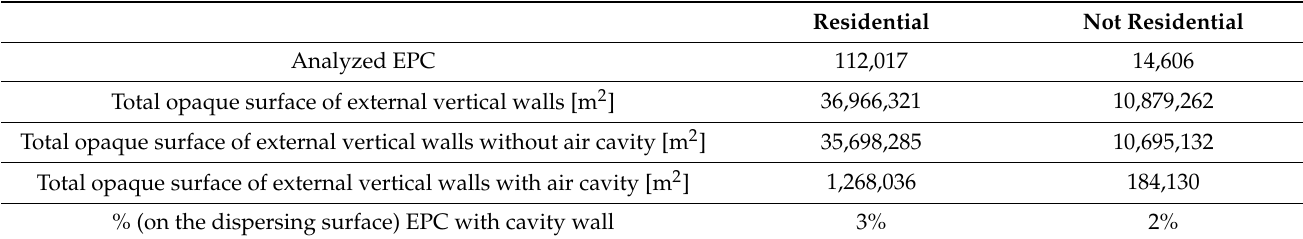
Table 10. Incidence of cavity walls in the analyzed EPC